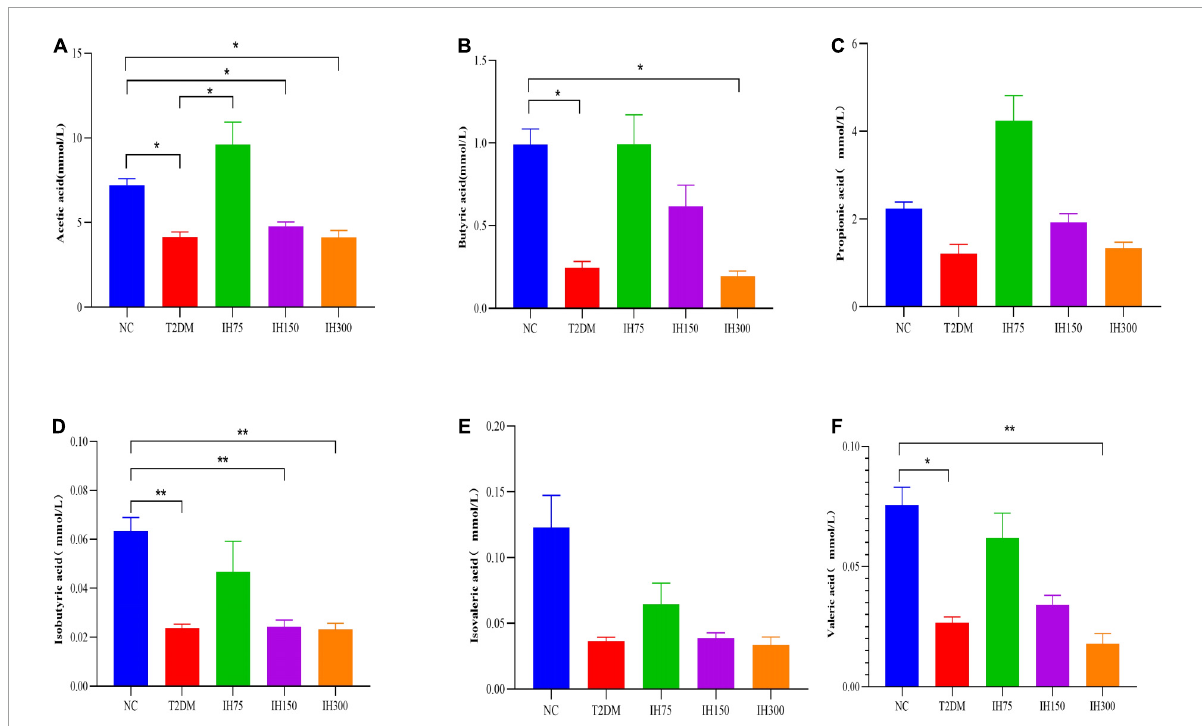
FIGURE10 Effect of IH on short-chain fatty acids in mice. Acetic acid (A) , butyric acid (B) , propionic acid (C) , isobutyric acid (D) , isovaleric acid (E) , and valeric acid (F) . All data are expressed as mean ± standard error of the mean (SEM). N = 6, P < 0.05 (*) and P < 0.01